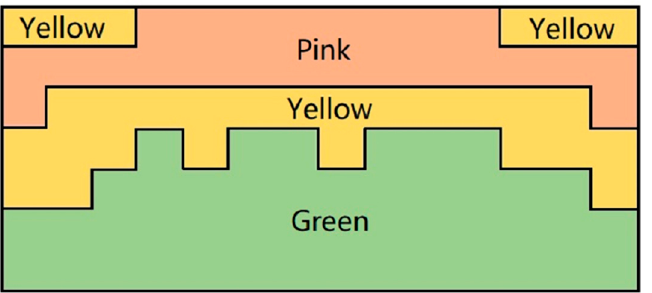
Figure 6. The priority domain distribution of sensor location in the open-plan office space.